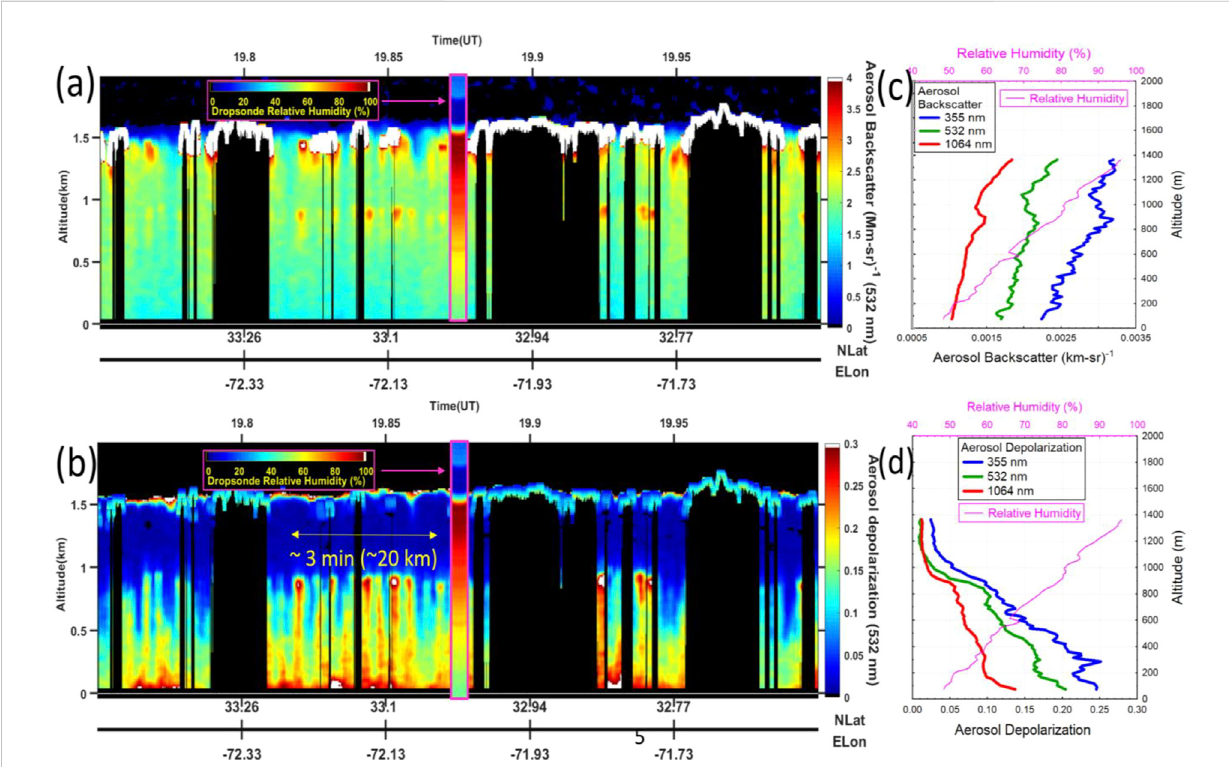
Expanded view of HSRL-2 pro fi les of (A) particulate backscatter (B) and particulate depolarization at 532 nm for the 8 March 2020 fl ight shown in Figure 1. Temporal resolution is 0.5 s (~50 m). Also shown in these fi gures is the RH from the dropsonde at 19:52 UT with its corresponding color bar shown atthetop.Cloudyareas areshown bythewhite areasinthebackscatterimages.Thickclouds completely attenuate thelaser lightleading to black stripes below these clouds. HSRL-2 multiwavelength pro fi les of (C) aerosol backscatter and (D) aerosol depolarization at the time of the dropsonde pro fi le are also shown along with the dropsonde pro fi le of